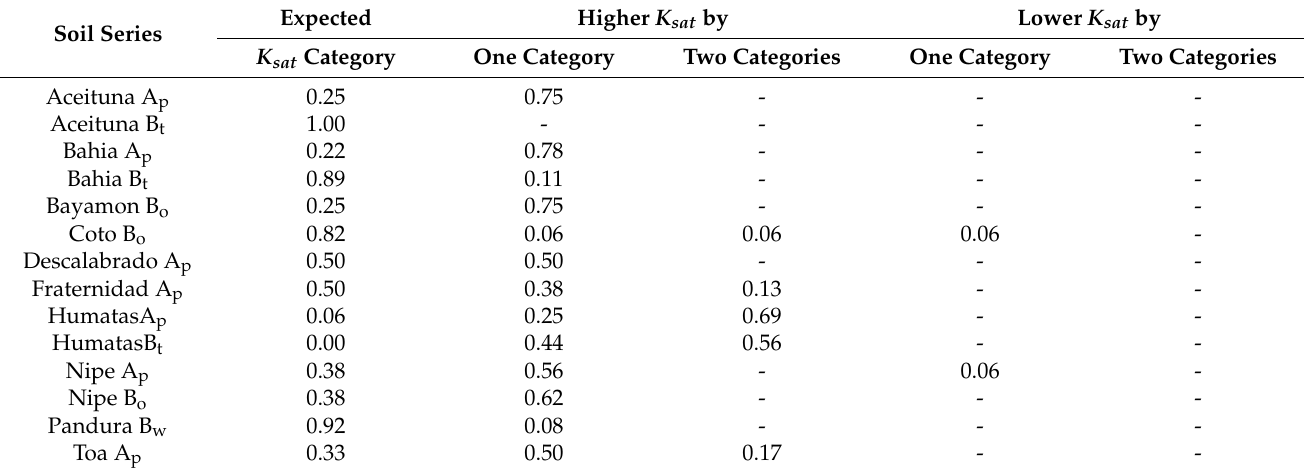
Table 6. Fraction of measured K sat values in expected classes, and in one or two classes higher or lower than the expected class.